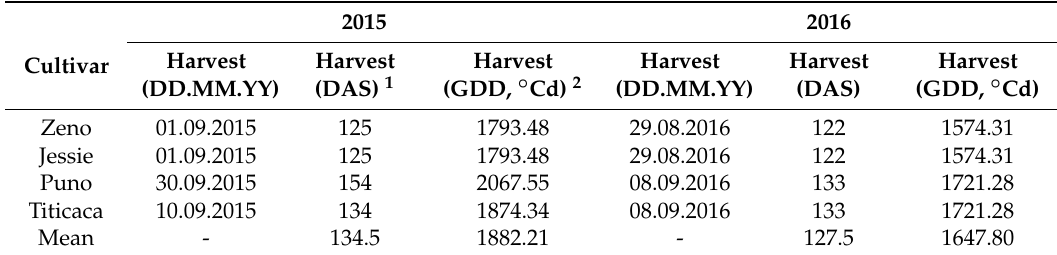
Table 3. Harvest dates in 2015 and